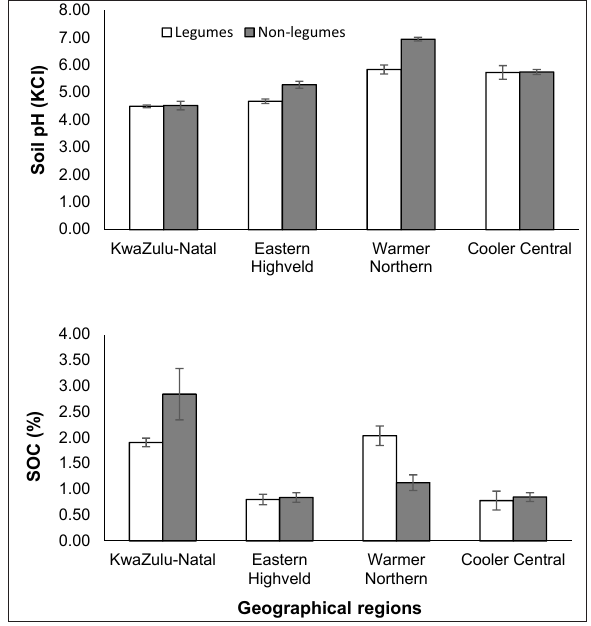
Figure 2 : Soil pH and organic carbon (SOC) variation (mean±s.e.) with crop rotation across different geographical regions of South Africa.